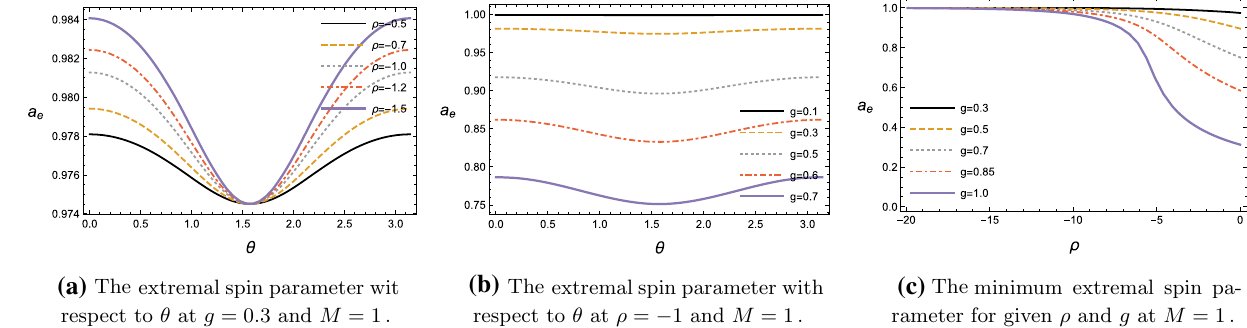
minimum extremal spin pa- rameter for given ρ and g at M = 1.